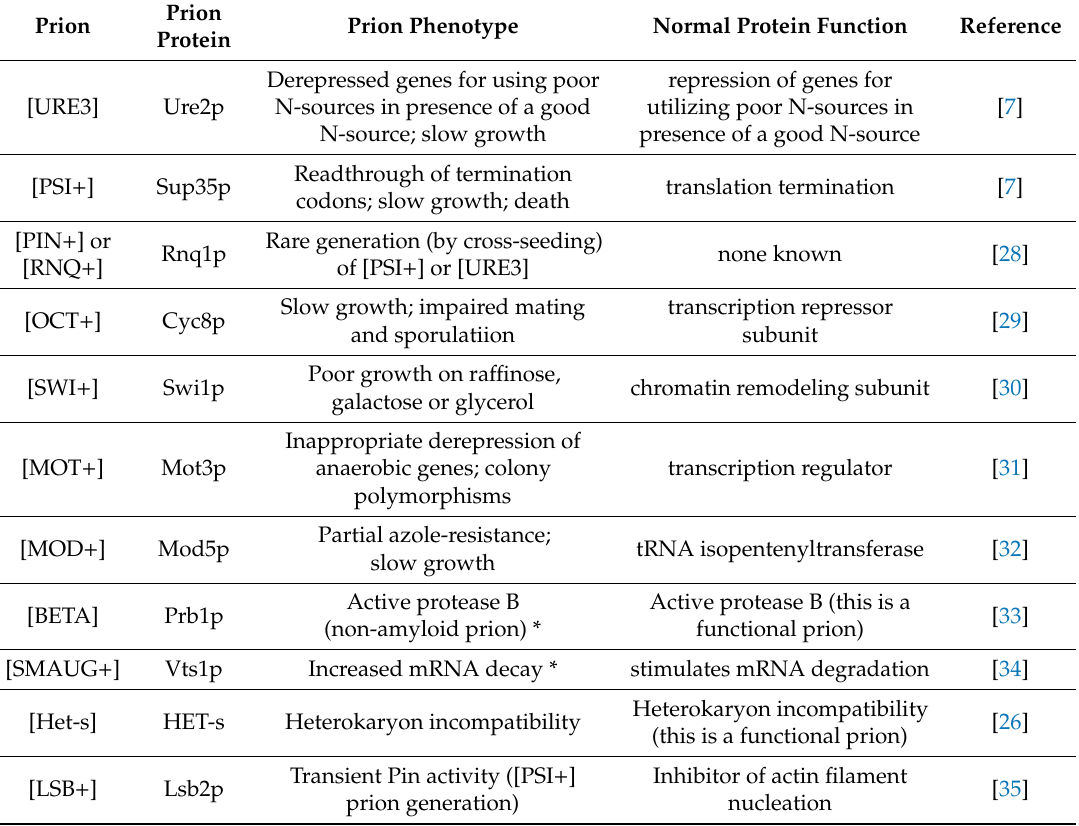
Table 1. Prions of yeast and